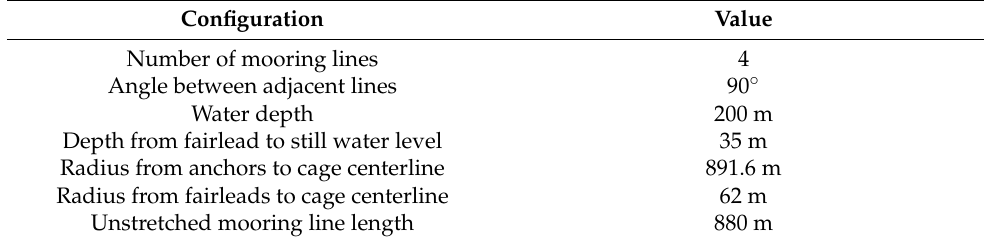
Table 3. Configurations of mooring line system.